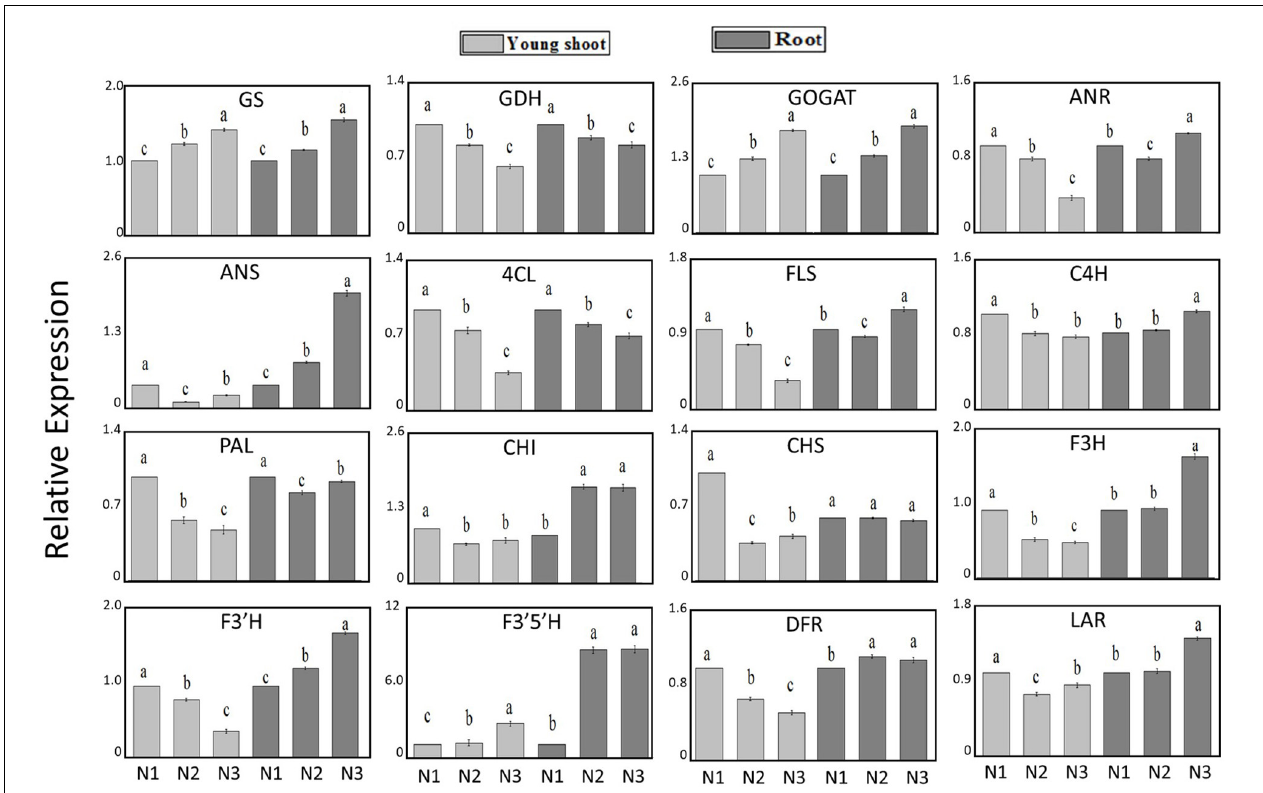
FIGURE 1 | Relative expression of genes GS, GDH, GOGAT, ANR, ANS, 4CL, FLS, C4H, PAL, CHI, CHS, F3H, F3‘H, F3‘5‘H, DFR , and LAR under conditions of low (0.3 mmol/L, N1), intermediate (1.5 mmol/L, N2), and high levels of nitrogen (4.5 mmol/L, N3) in young shoots, mature leaves, and roots based on UPLC-Q-TOF/MS and GC ×